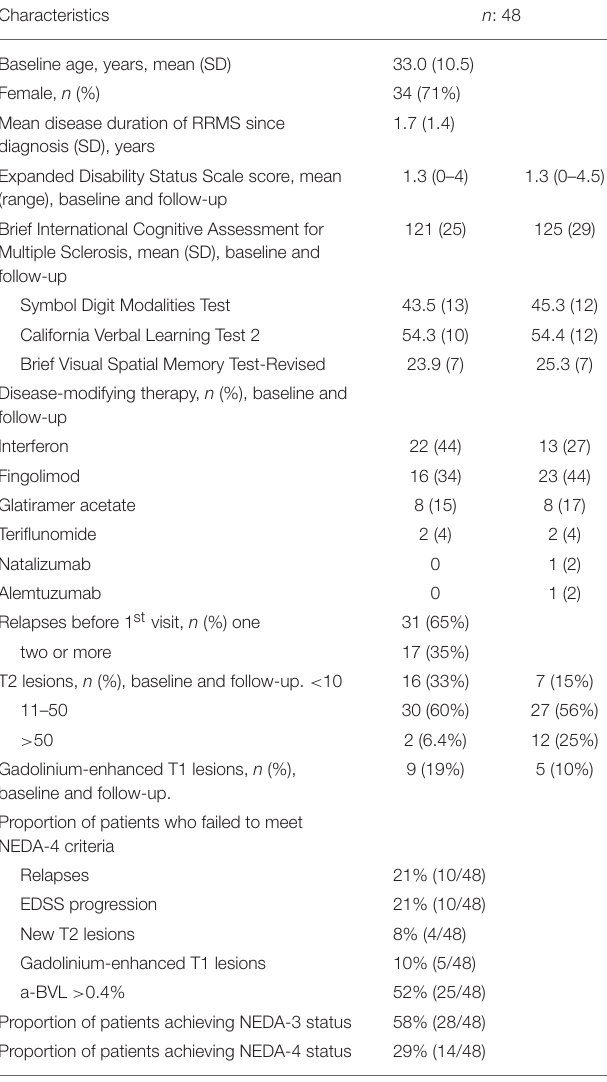
TABLE 1 | Baseline demographic and baseline and follow-up disease characteristics.